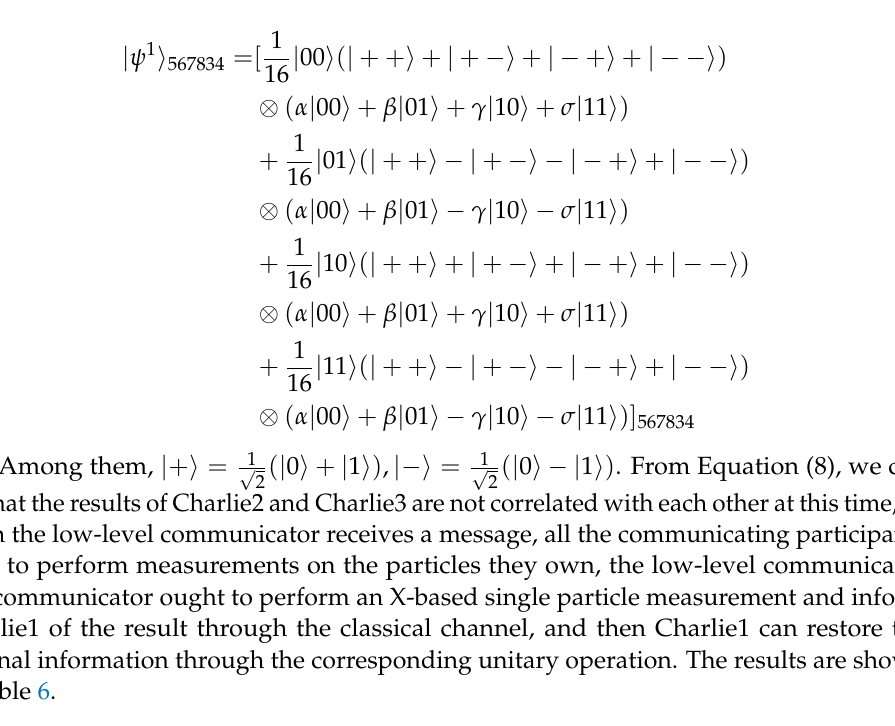
Table 5. The measurement results after Bob2, Charlie1, Charlie2, and Charlie3 performing the measurement, the state obtained by Bob1 and the corresponding unitary